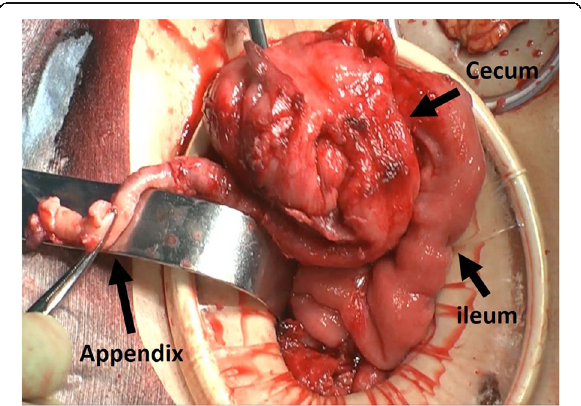
Fig. 2 Intraoperative finding: Drainage of the abscess and appendectomy were performed by the preoperative diagnosis of an acute appendicitis with an appendiceal mass. Although the body of the appendix looked intact as well as the ileum and the cecum, the histopathological examination revealed PAA in the tip of the resected appendix